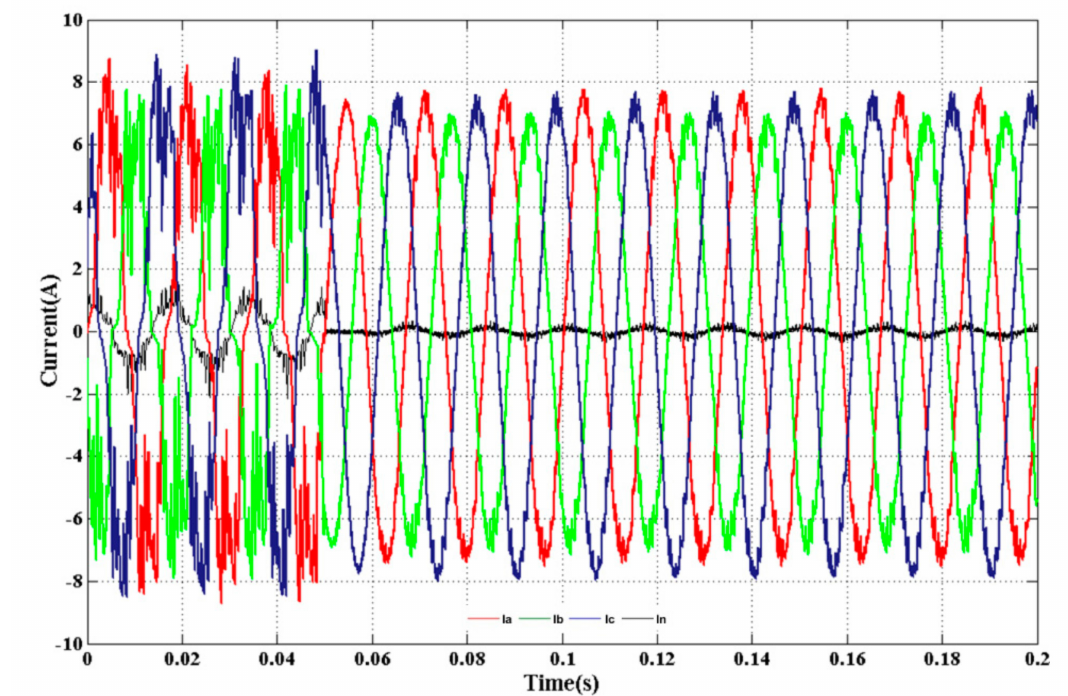
Figure 6. Experimental result of the sliding DFT for case 1.